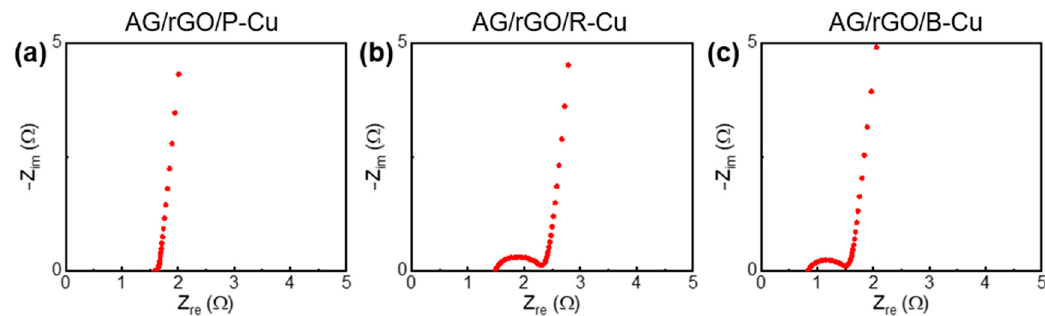
Figure 6. Nyquist plots of the supercapacitors using AG/rGO deposited on ( a ) P-Cu, ( b ) R-Cu, and ( c ) B-Cu mesh electrodes. The frequency ranges from 50 kHz to 0.1 Hz.